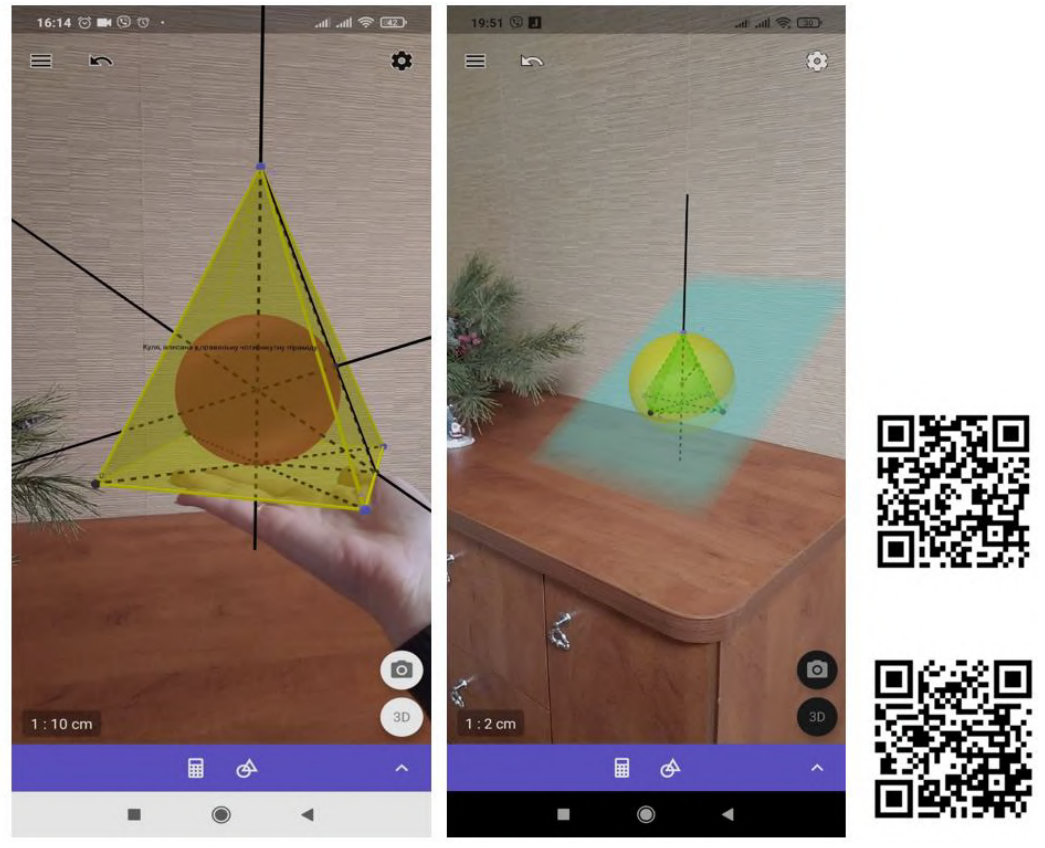
Figure 24: Presentation of paper